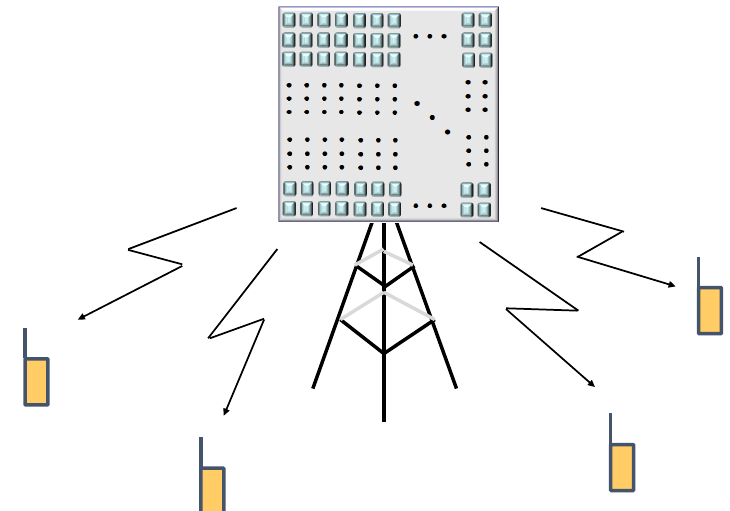
Figure 2. An example of a high level conceptual figure of a large-scale multiple-input multiple-output (LS-MIMO) system.